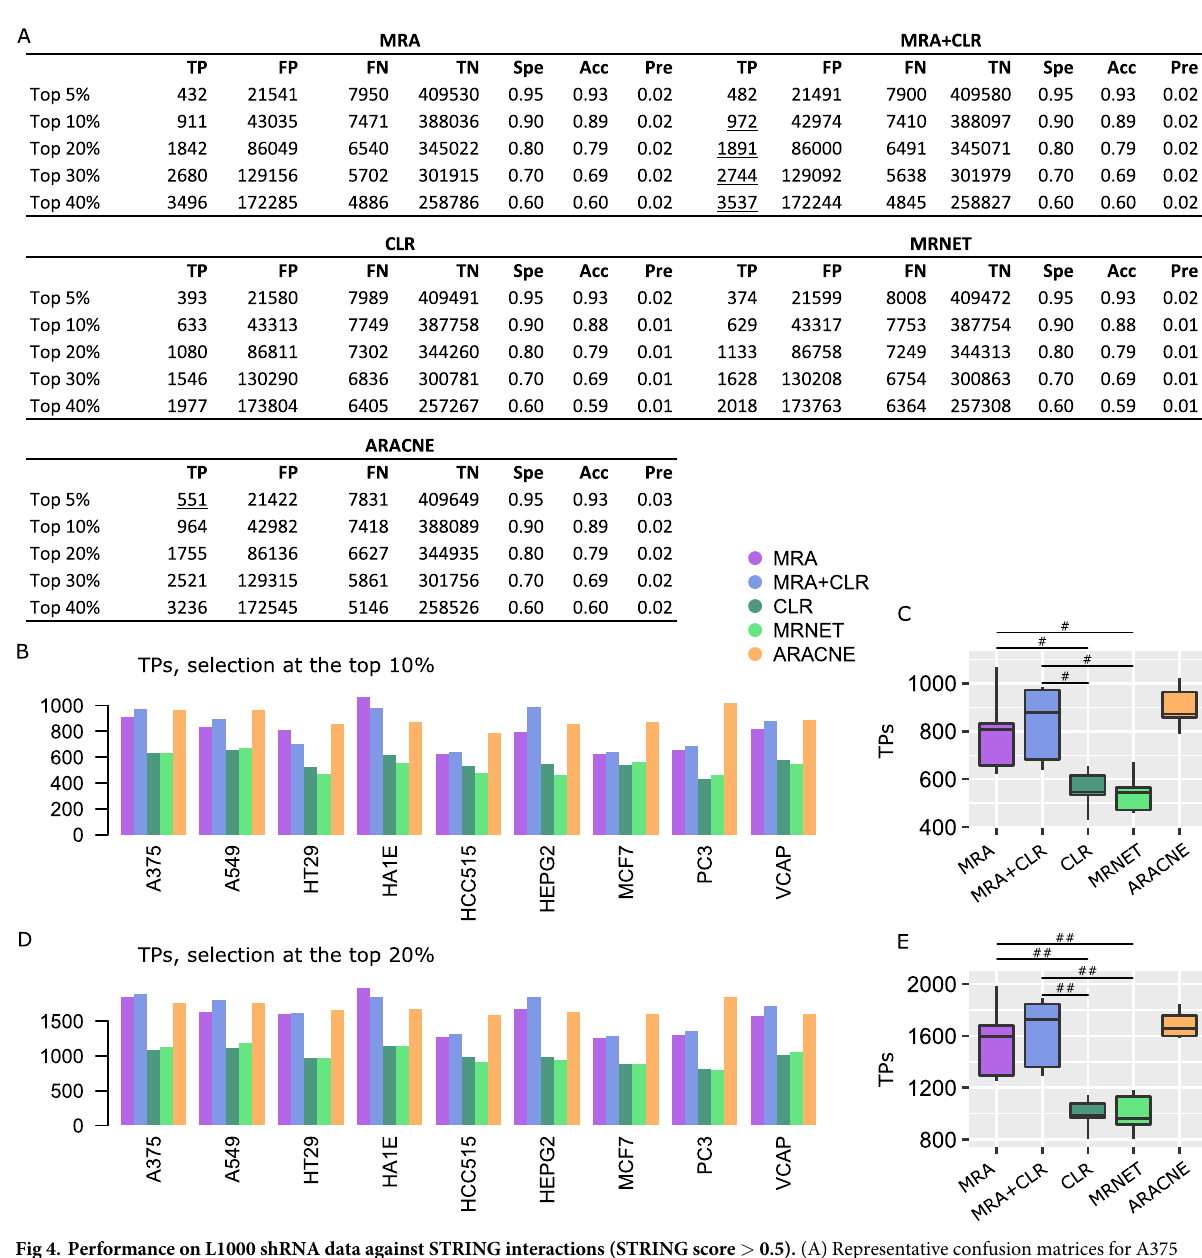
Fig 4. Performance on L1000 shRNA data against STRING interactions (STRING score > 0.5). (A) Representative confusion matrices for A375 cells. Spe = specificity, Acc = accuracy, and Pre = precision. Underlined values represent maxima. (B) TP numbers at the top 10% selection level.